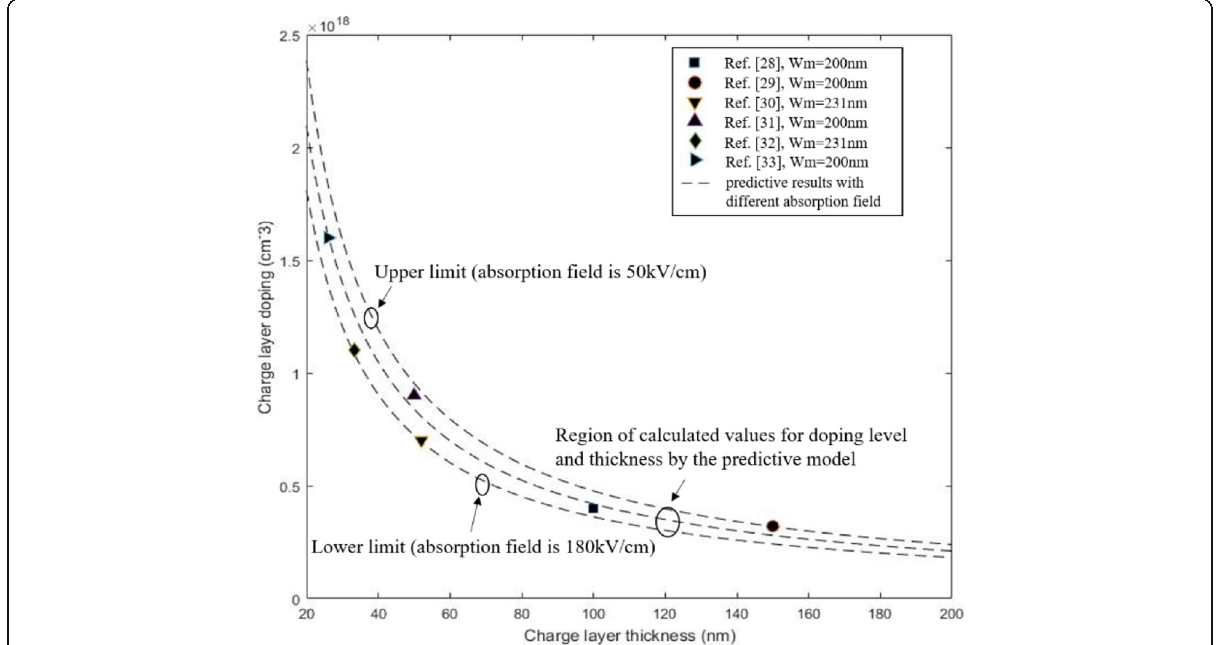
Fig. 2 Comparison of theoretical results and experiment data from various reports ( w m = 200 nm). Closed symbols: the doping level and thickness of charge layer with multiplication thickness of 200 nm (black square, black circle, black triangle, black right-pointing triangle) and 231 nm (black diamond, black down-pointing triangle) in the references. Presents the calculated values of charge layer (doping level and thick- ness) by Formula 8 (the absorption field is 50 – 180 kV/cm). When the absorption field is 50 kV/cm, the upper limit of the doping level in the charge layer can be obtained. When the absorption field is 180 kV/cm, the lower limit of the doping level in the charge layer can be obtained. We compare the theoretical results and experiment data from various reports. The region of theoretical values is in good agreement with the ex- perimental data. Dashed lines the calculated values of doping level and thickness by the